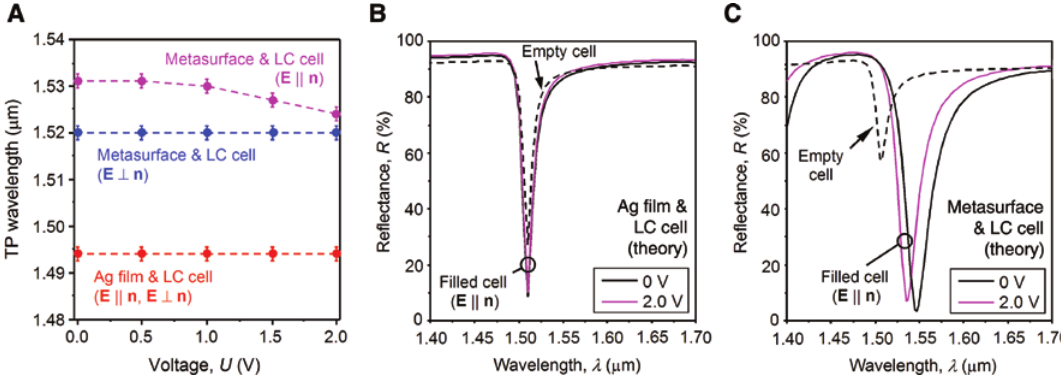
Figure 3: Electrical control of Tamm plasmons (experiment and theory). (A) Wavelengths of TP resonance plotted as functions of applied voltage. Data points were extracted from Figure 2A–C. Dashed curves are a guide for the eye. Panels (B) and (C) display the calculated reflectivity spectra of a continuous silver film and metasurface atop of a Bragg mirror integrated with an LC cell, respectively. Dashed curves show the reflectivity of the structures before the cell was filled with a liquid crystal. Solid curves correspond to the planar (black) and homeotropic (magenta) states of the liquid